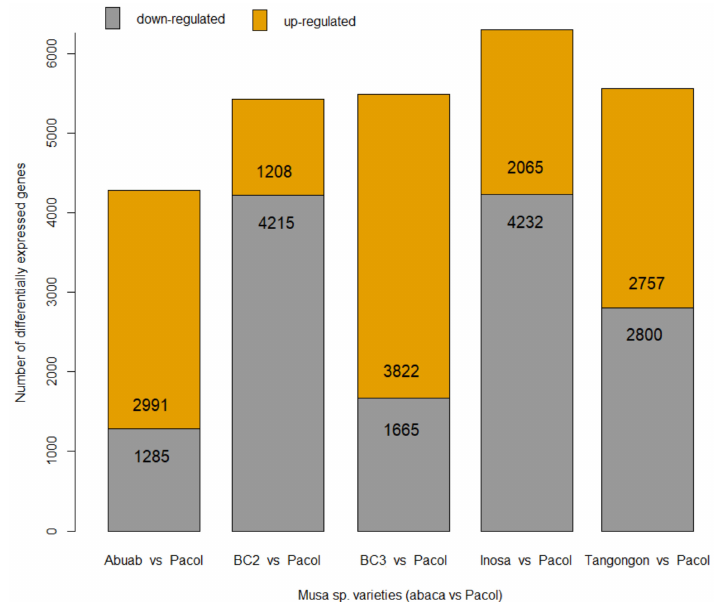
Figure 4. Number of up- and down-regulated DEGs (or transcript orthologs) between each abaca variety and